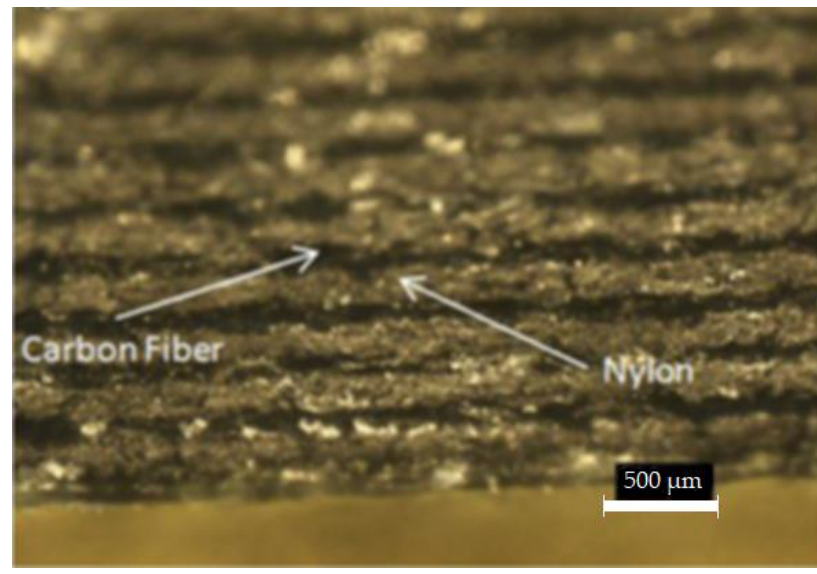
Figure 15. Optical microscopy of nylon-CF specimen.500 µm